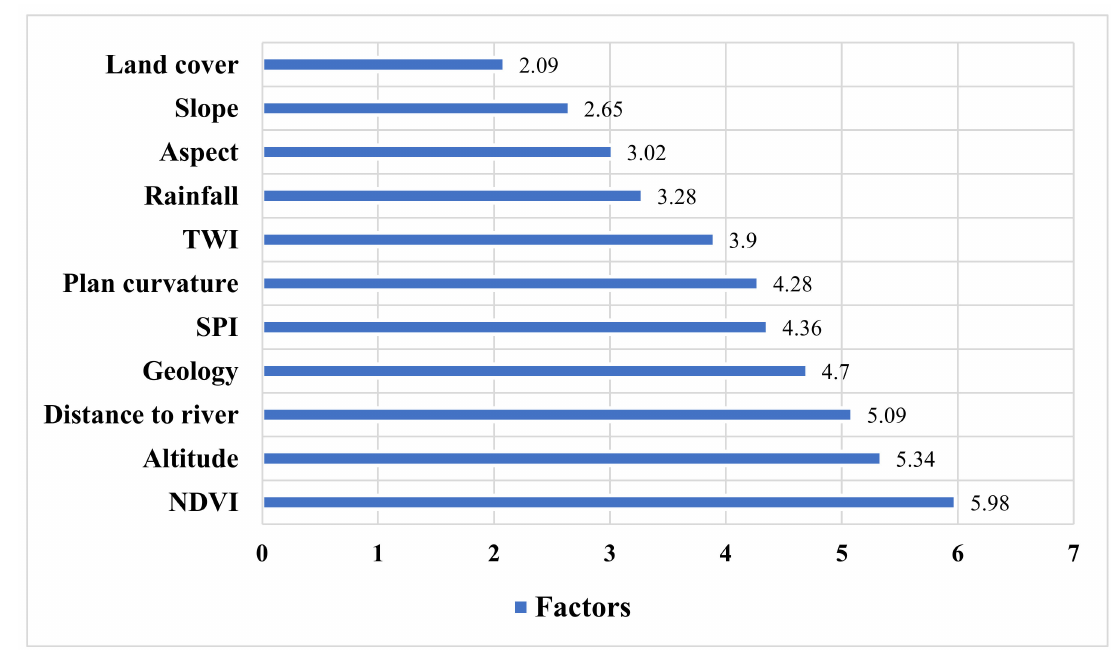
Figure 6. Importance of factors using pairwise